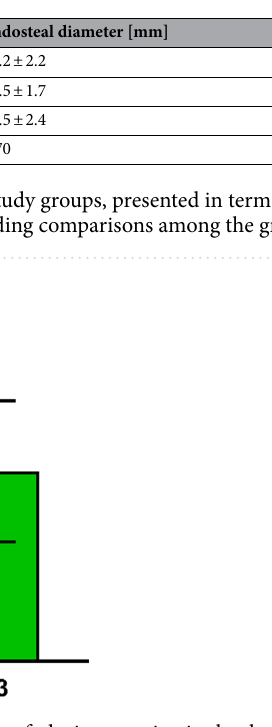
Figure 2. Total calculated volume of harvested bone graft during reaming in the three study groups G1, G2 and G3 in terms of mean value and standard deviation, with stars indicating significant differences.